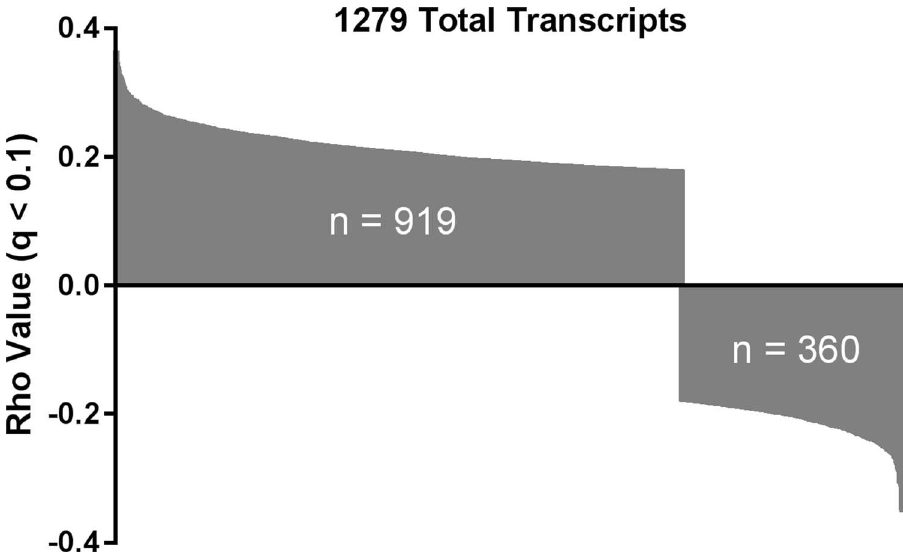
Fig 2. mRNA expressionof 1279 genes significantly correlateswith pSTAT3(Y705) protein expression. A positive correlationbetweenmRNA expressionand pSTAT3(Y705) expressionwas observed for 919 genes, while a negativecorrelationwas observedfor 360